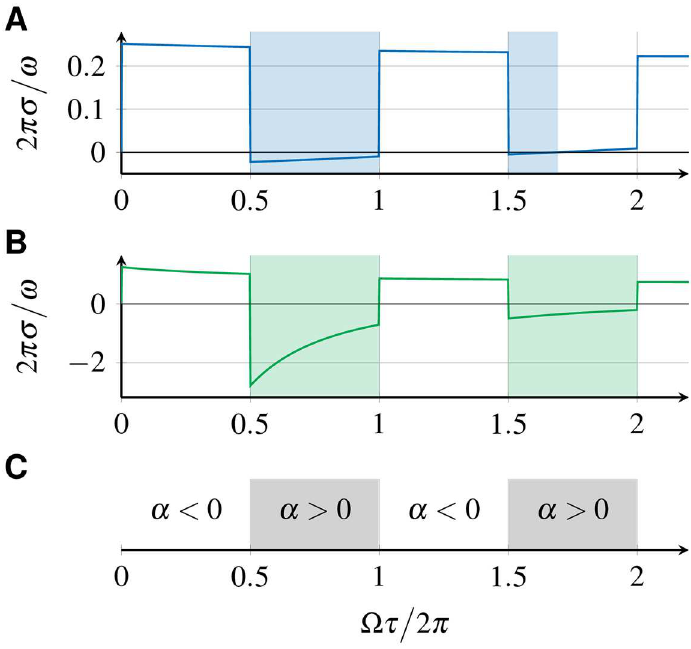
Fig 7. Perturbation response rate σ of the in-phase synchronized state for two coupled DPLLs. Perturbation responserate σ of the in-phase synchronizedstate in a system of two mutually coupledDPLLs, definedby Eq (17), for ^ p given by Eq (29) with (A) a = 1 and ω c = 0.01 ω and (B) a = 0. (C) Sign of α , Eq (14), as a function of the transmissiondelay. In all plots, shadedregions indicatewhere the in-phasesynchronized state is stable. Regionswhere α > 0 coincidewith the stability regions in (B). The other parameters are o ¼ 2 p rad s (cid:0) 1 , K = 0.1 ω